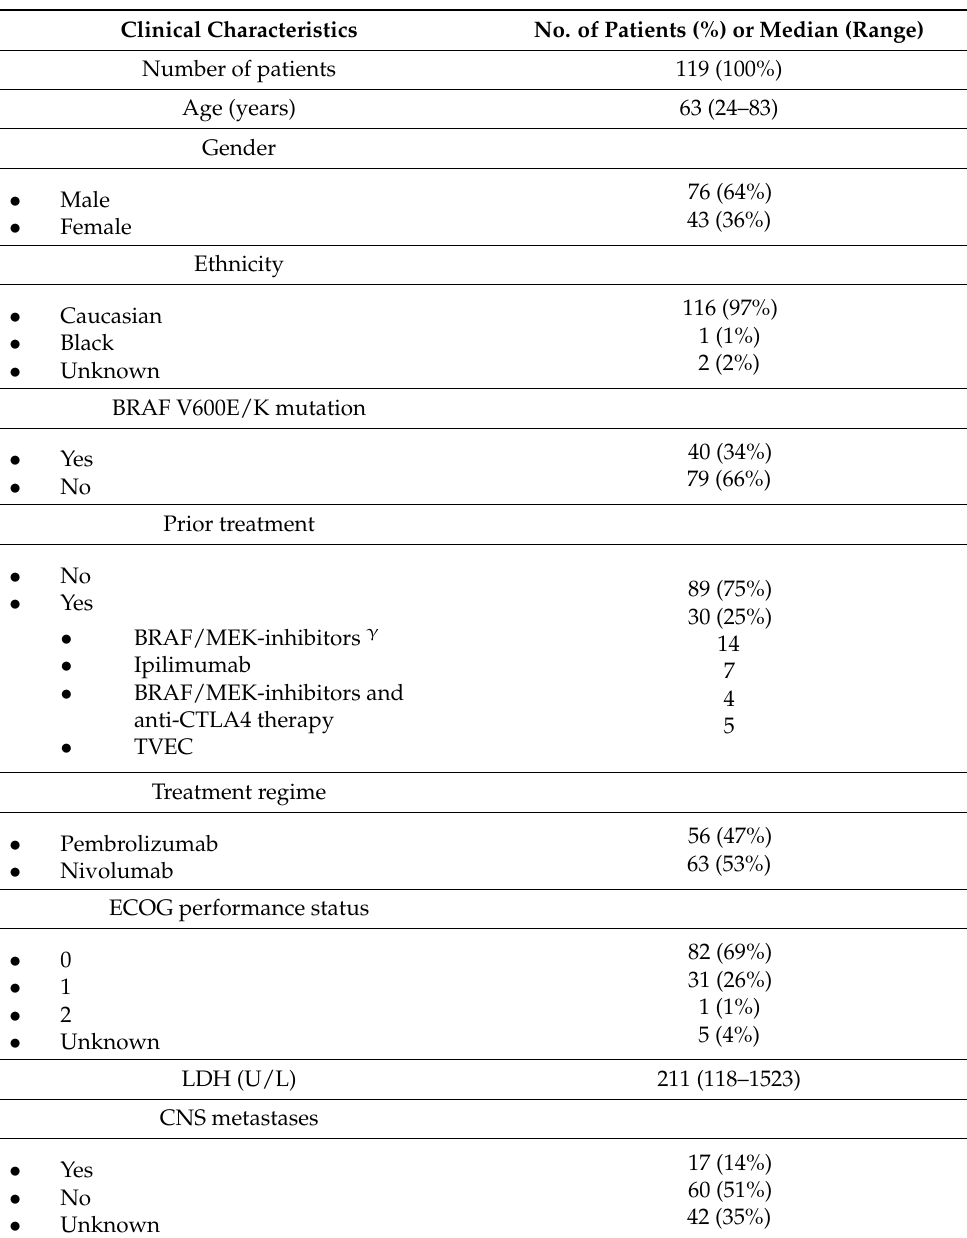
Table showing the baseline patients’ characteristics of all patients in the study ( n = 119). Abbreviations: TVEC: talimogene laherparepvec; ECOG: Eastern Cooperative Oncology Group; LDH: Serum lactate dehydrogenase; U: Units; L: Liter; CNS: central nervous system. γ i.e., vemurafenib and cobimetinib, dabrafenib and